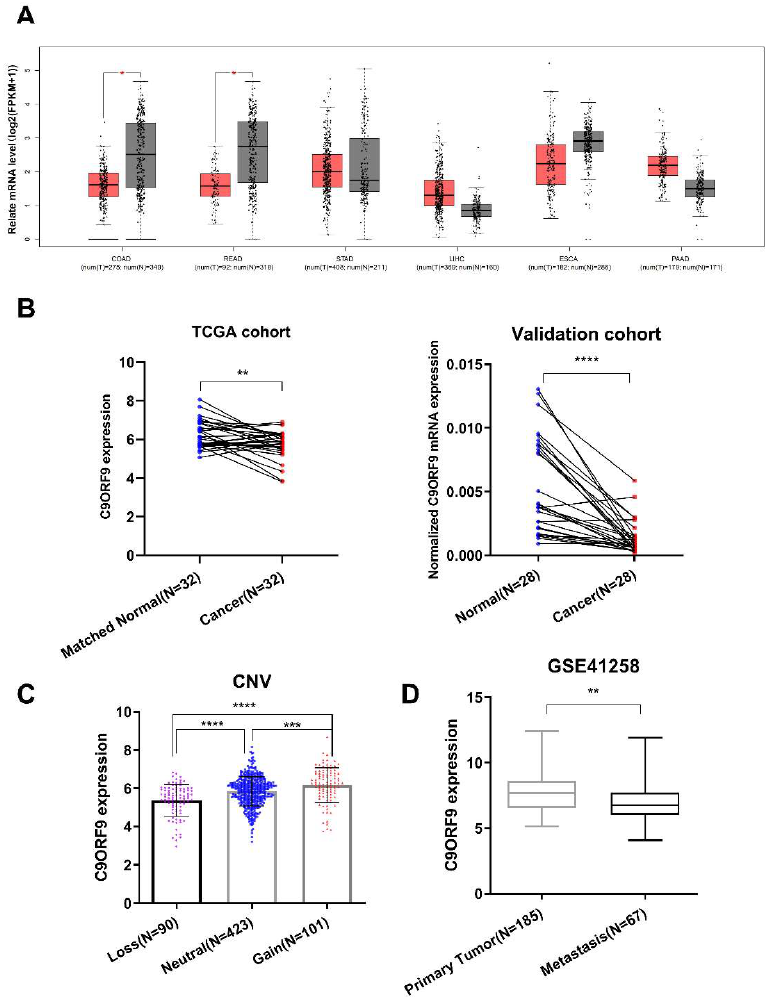
Figure 2. Gene expression analysis of C9orf9 in multiple samples of digestive tumor patients . ( A ). Analysis of C9orf9 expression in five digestive tumors from TCGA and GTEx samples. * p < 0.05. T: tumor (red), N: normal (grey). ( B ). C9orf9 expression level in tumor and matched normal tissues from TCGA and local validation cohort. ** p < 0.01, *** p < 0.001. ( C ). Correlation between copy number variation (CNV) and C9orf9 expression level in TCGA cohort. **** p < 0.0001. ( D ). C9orf9 is downregulated in metastatic tumor samples of CRC, data from GSE41258. ** p < 0.01. Table 2. Correlation of C9orf9 expression to clinical variables of TCGA CRC samples. C9orf9 Expression Variables Cases